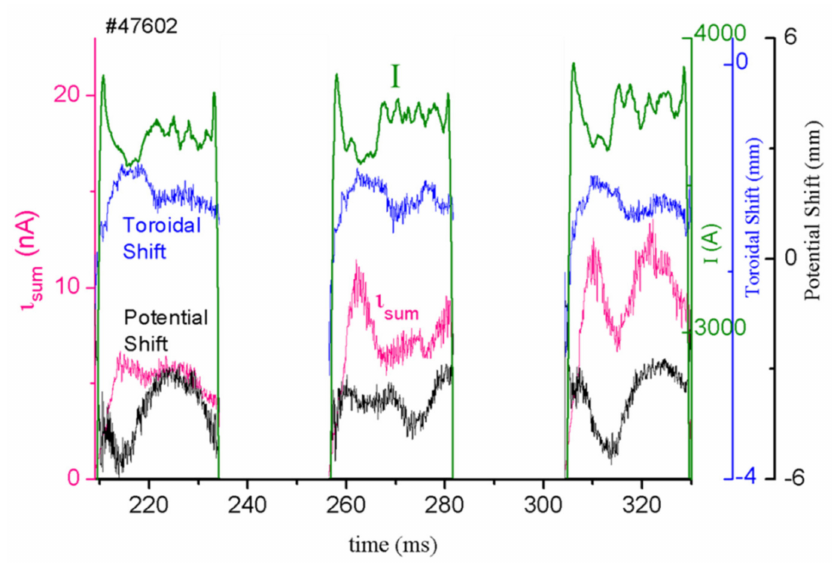
Figure 27. Raw signals of the fluctuations of the secondary beam position and intensity at the CEA front and back